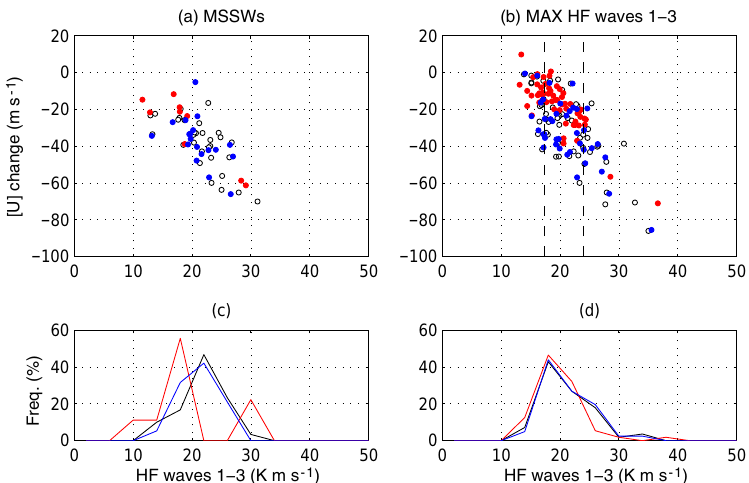
Figure 10. (a) Scatter plot between 21-day mean heat flux (lag =− 20 to 0 day) of waves 1–3 and associated zonal wind deceleration for the 21 days for all MSSWs in STDD (black), CONV (blue), and AMIP (red). Panel (b) is similar but uses the maximum of the 21-day mean heat flux of waves 1–3 in each DJF season as the key. The vertical broken lines denote the 25th and 75th percentile values of the heat flux in STDD, which is used for the composite analysis in Fig. 11. Panels (c, d) show frequency distributions of the 21-day mean heat flux for the respective cases. The full period data are used for